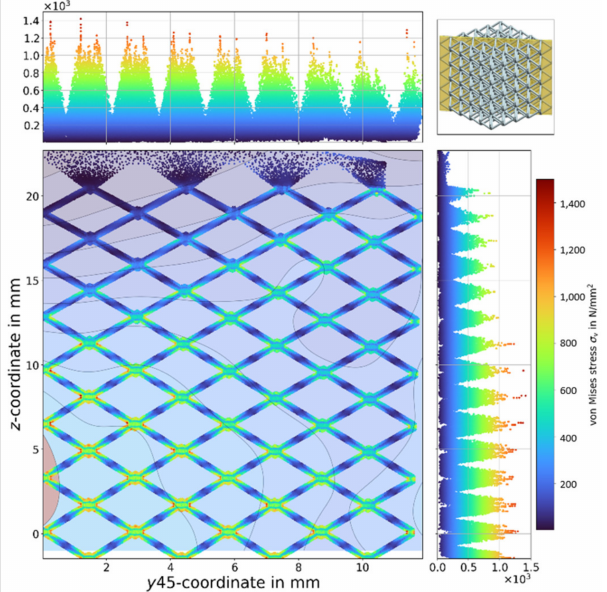
Figure 14. Von Mises stress of the bcc lattice with cones as the load introduction feature— diagonal view